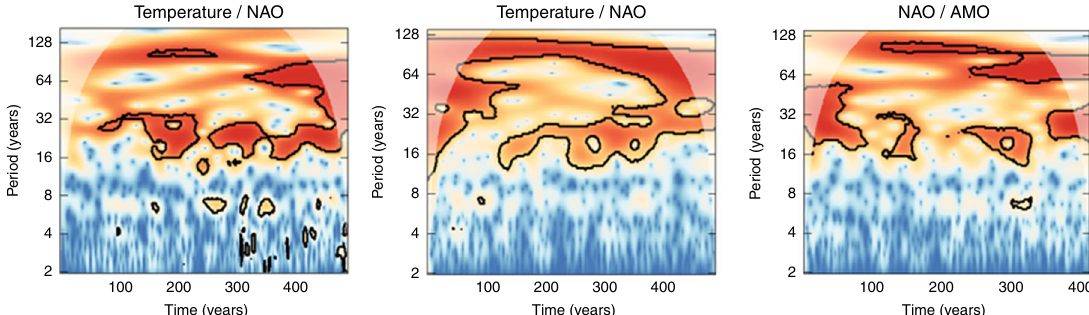
Fig. 10 Cross-wavelet analysis between major hydroclimatic drivers. Similar to Fig. 9 but for cross-wavelets between temperature, NAO and